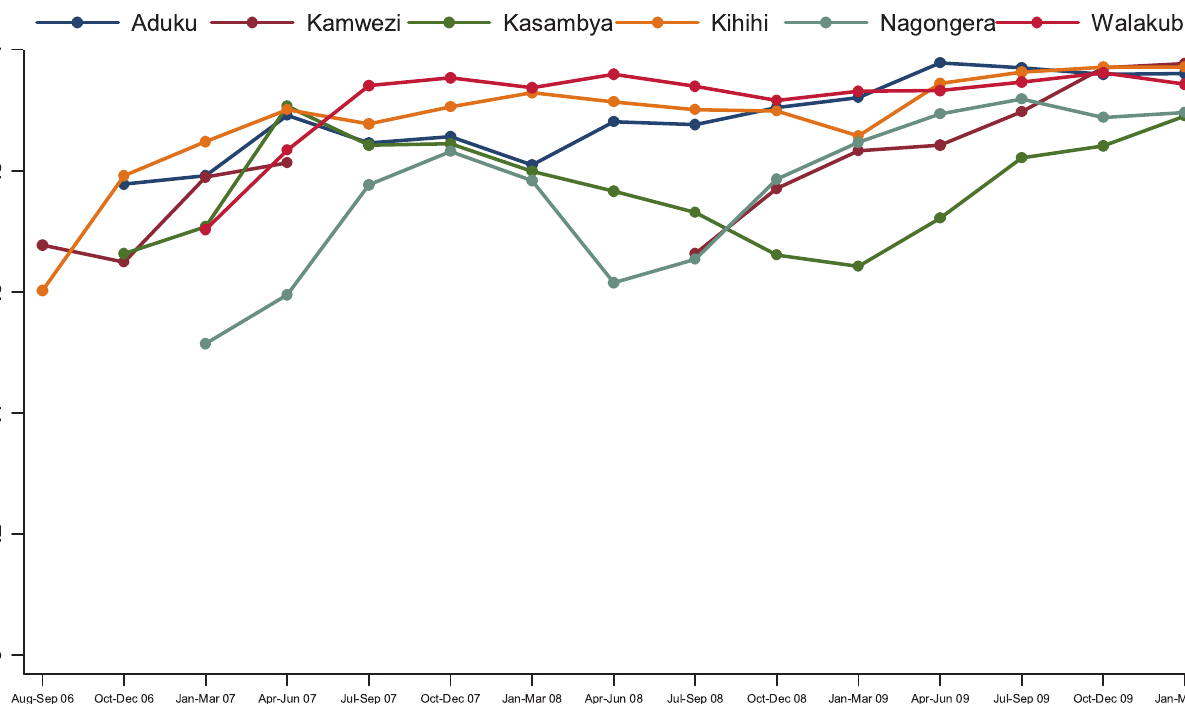
Figure 4. Proportion of patients with diagnostic test done with appropriate decision to prescribe antimalarial therapy by quarter and stratified by site.